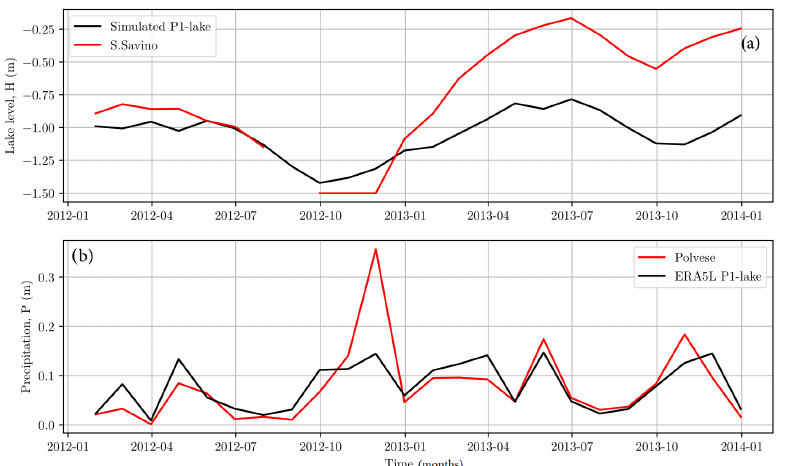
Figure 10. Comparison between ERA5L and ground-based observed data for the intense precipitation period 2012–2013: ( a ) monthly lake level, H , from ERA5L P1-Lake (in black) and the observed one at S. Savino station (in red); ( b ) precipitation over the lake (m/month), P , from ERA5L P1-Lake (in black) and the observed one at Polvese station (in